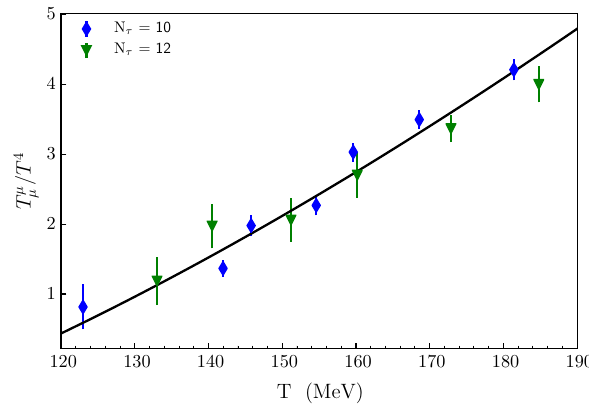
μ μ Fig. 3 The trace anomaly, T , plotted as a function of temperature for T 4 the low temperature region. The points represent lattice QCD results (Fig. 2 of Reference [3]). The different N τ values refer to the number of lattice cells in the imaginary time direction. The full curve is the chi- square minimization fit obtained with the approach described in 4.2. The full curve represents the M theory result, Eqs. (40) and (43)